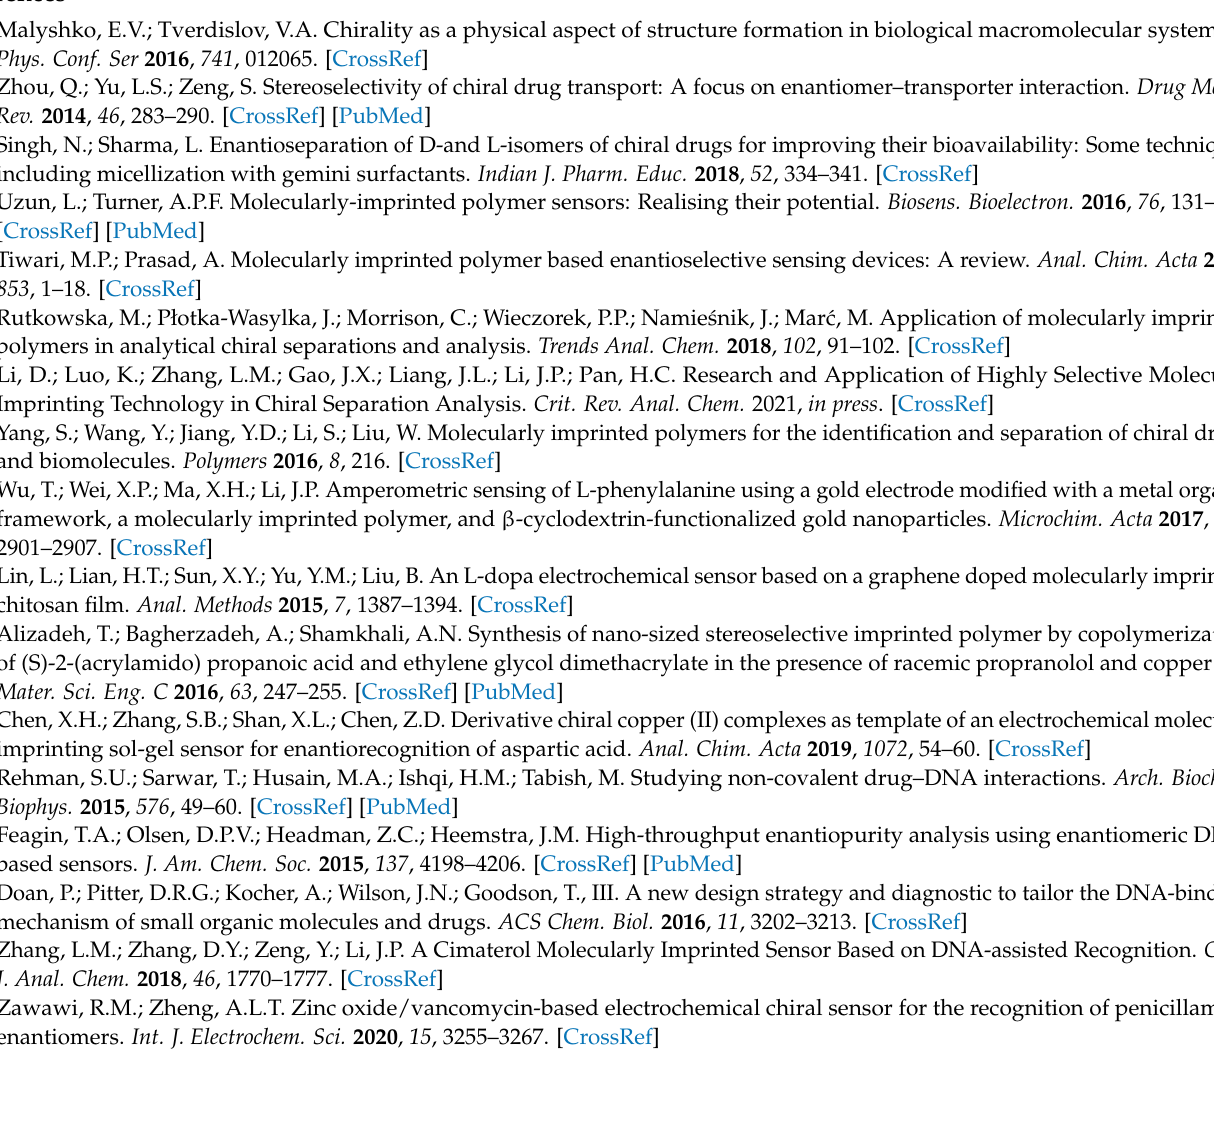
Table S2: Comparison of performance between this method and other methods for detecting